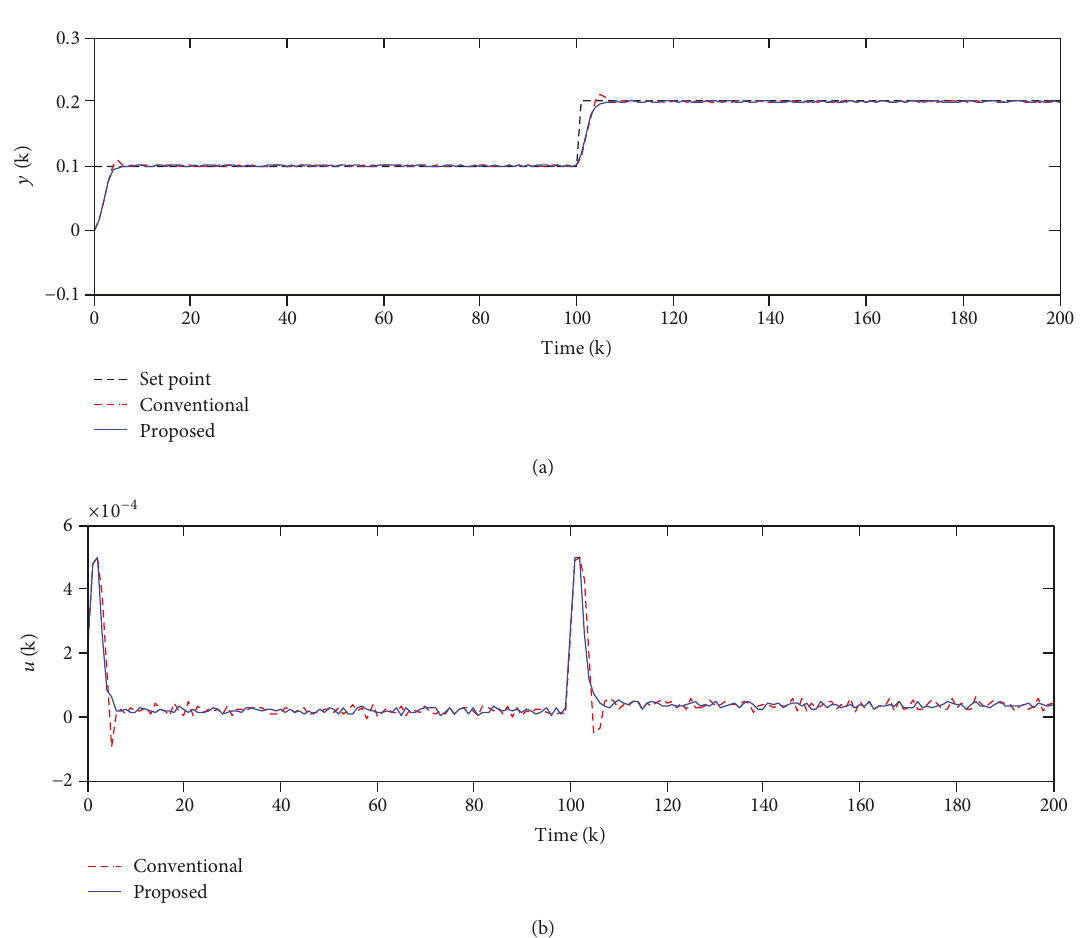
Figure 6: (a) Output response and (b) control input under the proposed and conventional